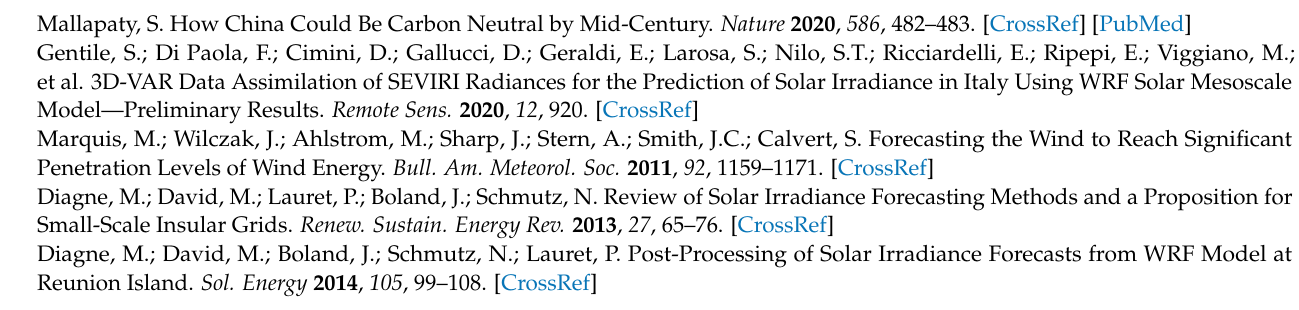
mean AODs; Figure S2: The locations of the SSR stations and their types; Figure S3: The mean wind speed for the observed stations and the simulated ones in FR experiment from 8 to 22 March 2021; Figure S4: Probability density distribution of the observed versus the simulated hourly GHI under clear skies for the (a) OR, (b) FR and (c) DA experiments in urban stations from 8 to 22 March 2021. The continuous black line is the 1:1 line, and the dashed black lines correspond to the 1:2 and 2:1 lines. (d) Frequency distributions of deviations (modeled GHI minus observed GHI under clear skies) from the observations. The percentages of deviations between ± 0.05, ± 0.1, < − 0.5, and >0.5 are also shown. Table S1: The comparison of the hourly observational GHI with simulated ones in OR, FR, and DA experiments in seven electricity regions, only urban stations are